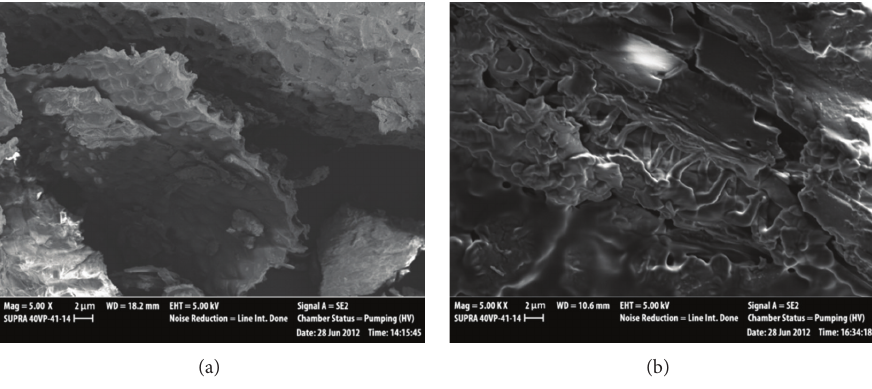
Figure 2: SEM images of (a) SSC and (b)